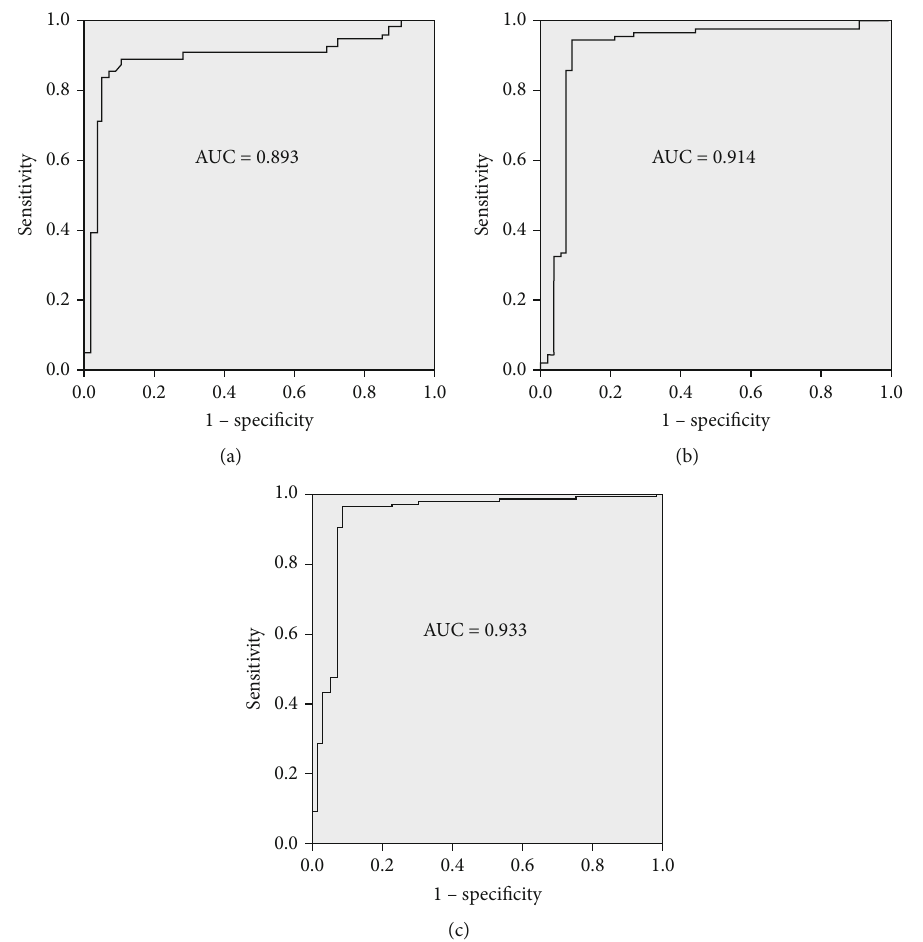
Figure 2: ROC curve analysis was used for categorizing the severity of CAD patients: (a) healthy controls and single-vessel lesion CAD (AUC 0.893); (b) dual-vessel stenosis CAD with healthy subjects (AUC 0.914); (c) healthy volunteers and multivessel blocked CAD patients (AUC 0.933).